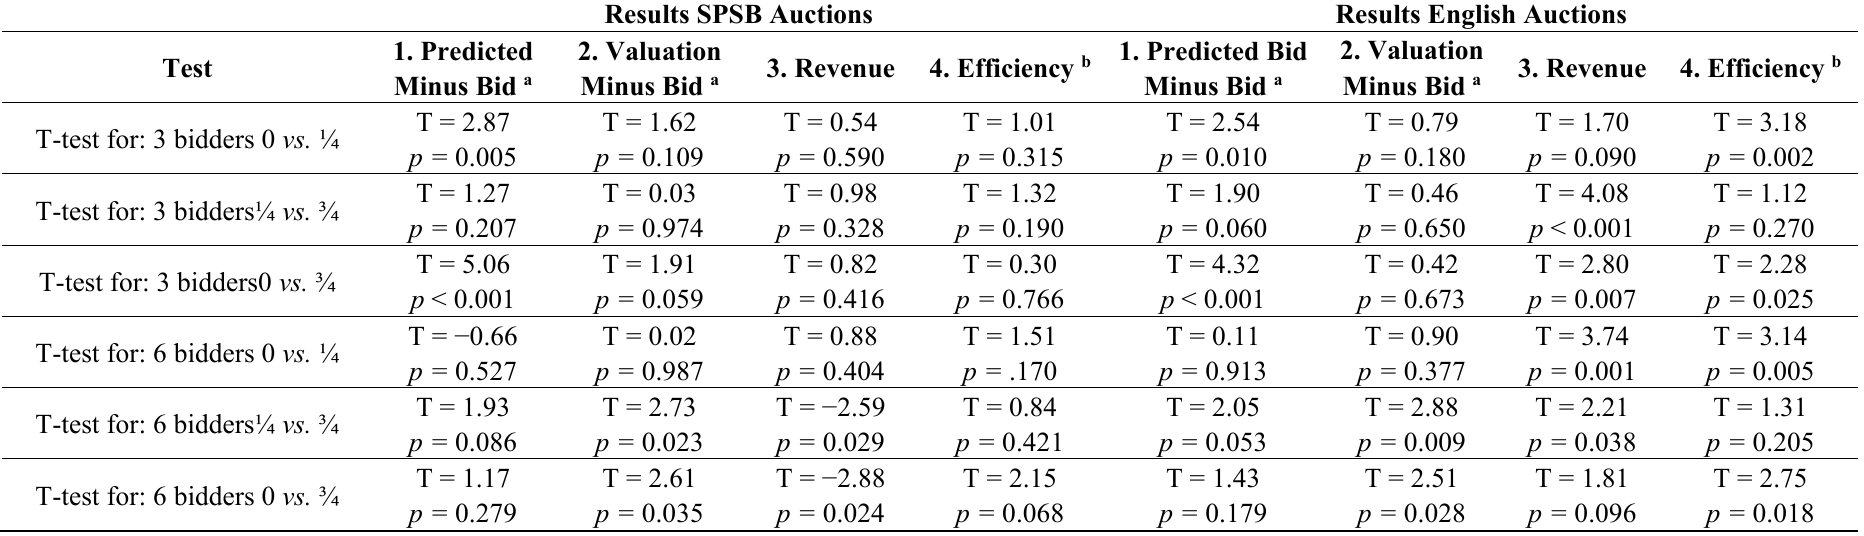
Table 3. T-tests for significance of different outcome from Table 2, for different conditions (multipliers and number of bidders). (T-statistics and p -values